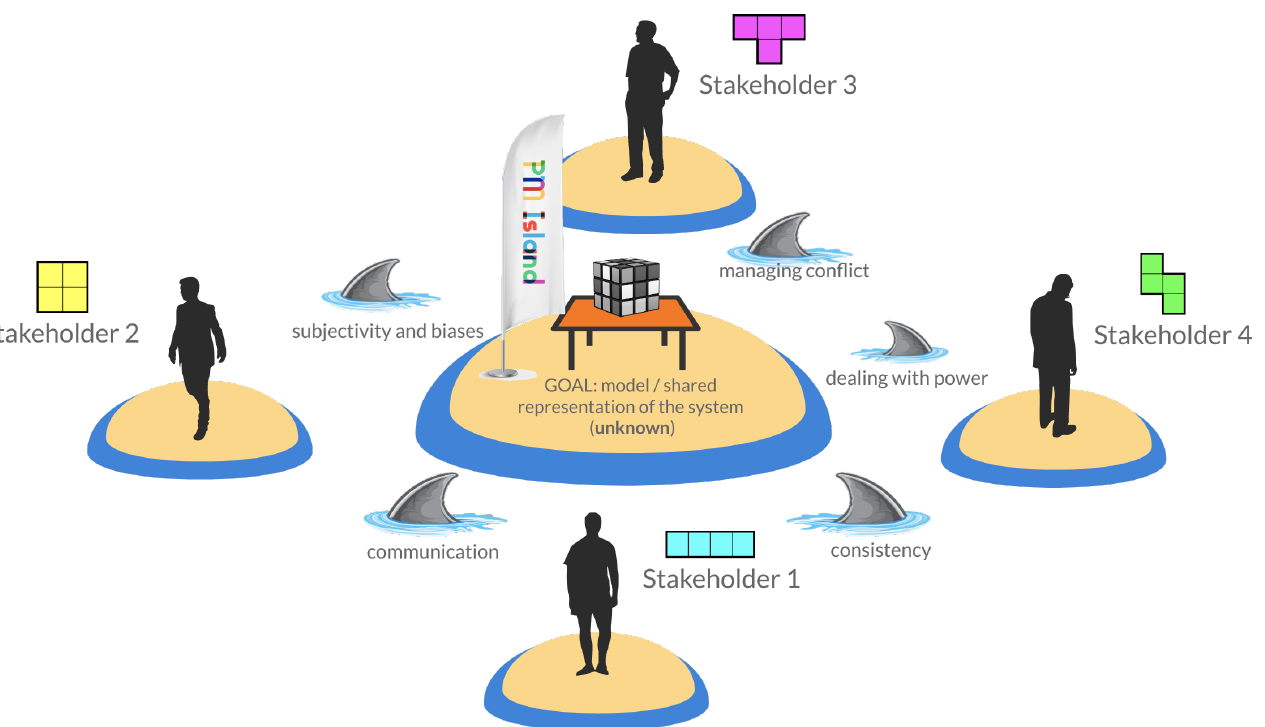
Figure 2. Often, cognitive and behavioural barriers can go undetected and limit, or even trump the success of any PM exercise which fails to account for how these factors might manifest in any given stakeholder workshop. We can group these human barriers into five categories: subjectivity and biases; managing conflict; dealing with power; communication; and consistency. Each of these barriers can show up to varying degrees in any PM exercise. Collectively or individually, they can prevent stakeholders from bringing their unique mental models together to achieve the ultimate goal of establishing a ’shared understanding’ through the modelling